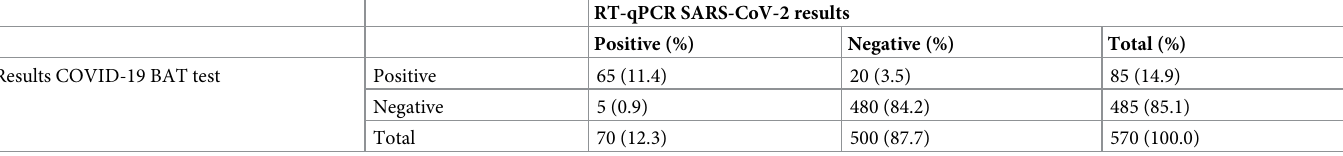
Table 2. Results from RT-qPCR and BAT for the entire